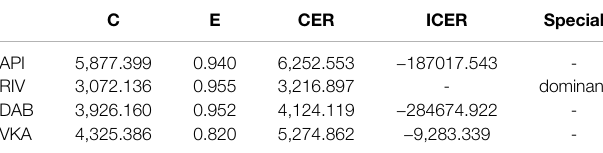
TABLE 5 | Base-case results.